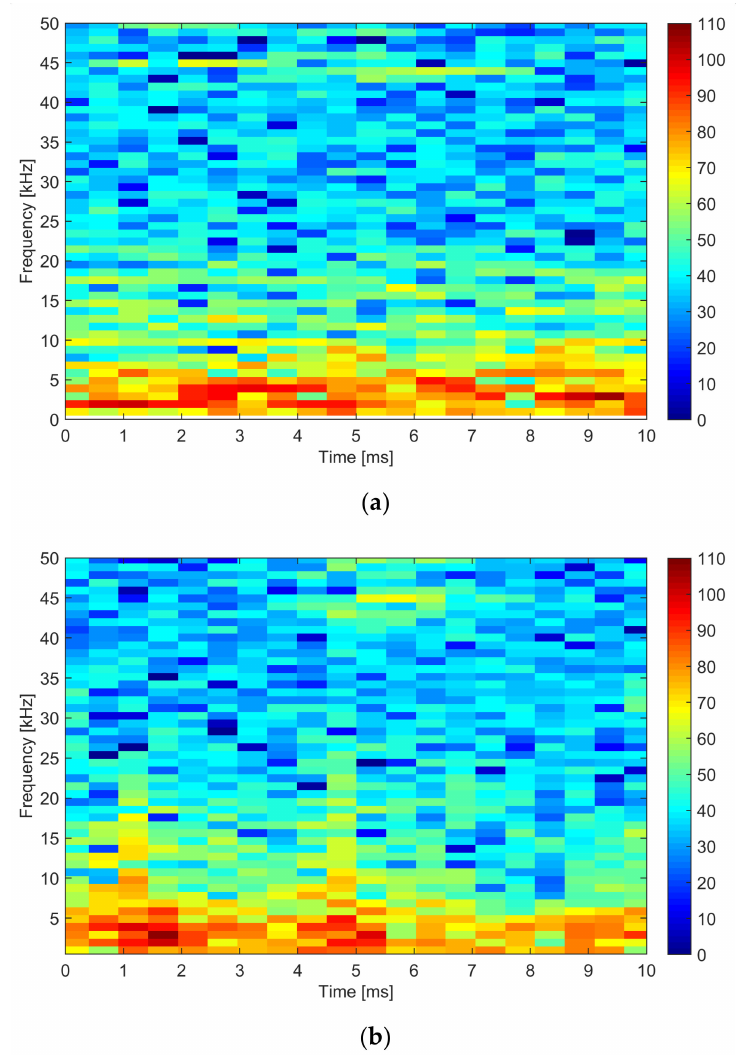
Figure 7. Comparison of two di ff erent wavelets in relation to localization on the time axis and spread to adjacent frequency bins; frequency resolution ∆ f = 976 Hz, number of levels L = 9: ( a ) db15 ; and ( b ) sym8 . SMPS type Black at 90% of rated